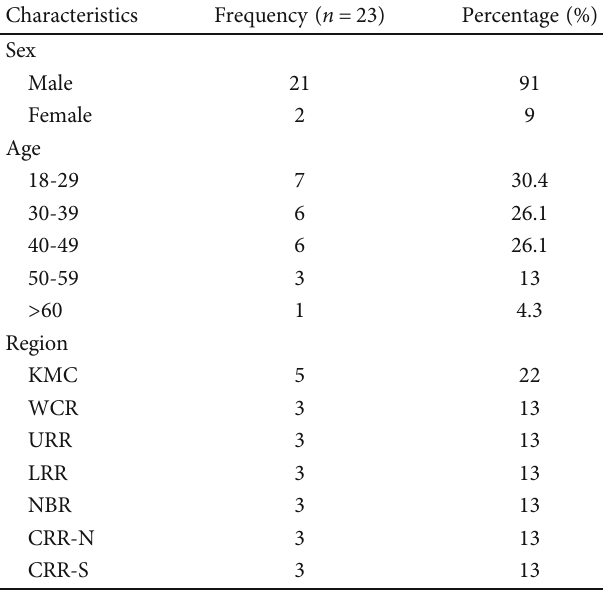
Table 2: Demographic pro fi le of livestock assistants from The Gambia,